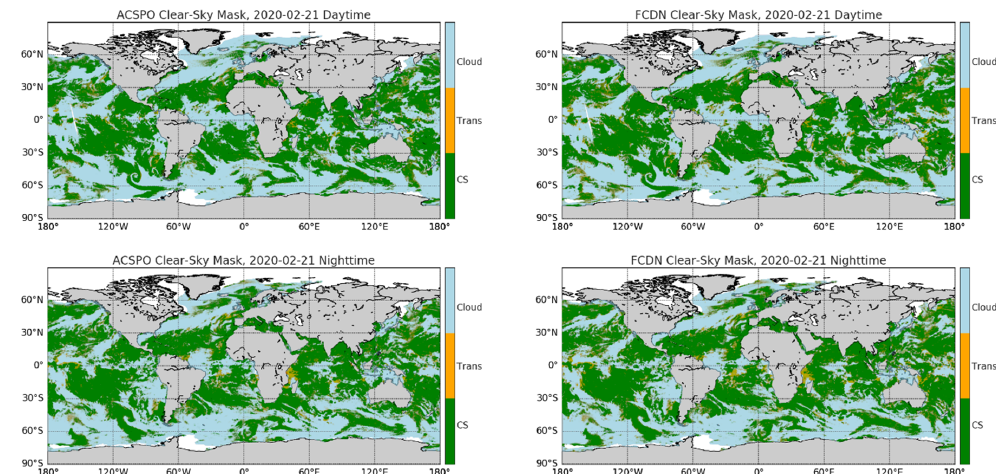
Figure 1. Global distribution of CSM types Advanced Clear-Sky Processor over Ocean (ACSPO) (actual) and FCDN_CSM (predicted) on 02/21/2020, including Clear-Sky pixels (CS), cloud pixels (Cloud), and transition pixels between Clear-Sky and Cloud (Trans).